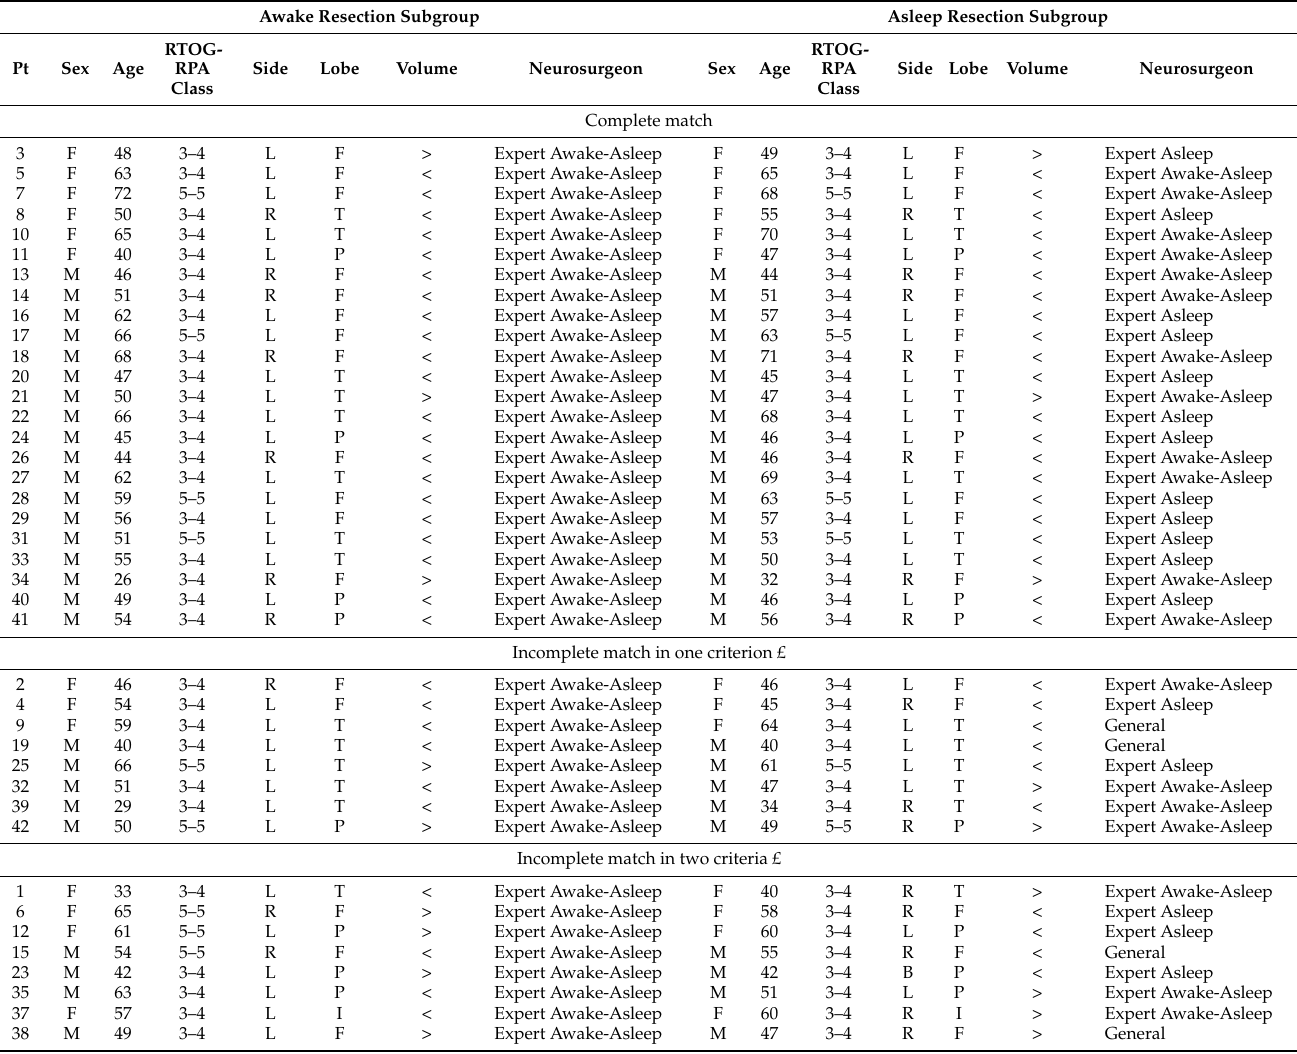
Table 1. Awake resection and asleep resection subgroups paired by matching